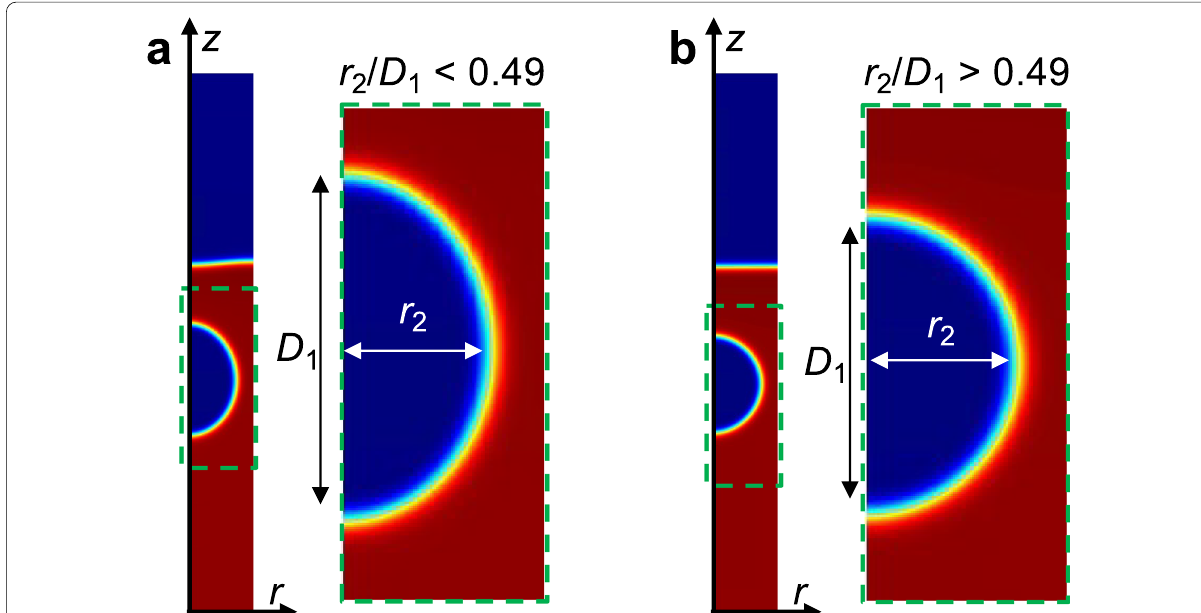
Fig. 3 Criterion for simulation time ( t a ); t a is determined from the moment when cavity evolves into a sphere ( r 2 / D 1 > 0.49 ), while simulation continues to 30 × t r (6000 s) for parametric study